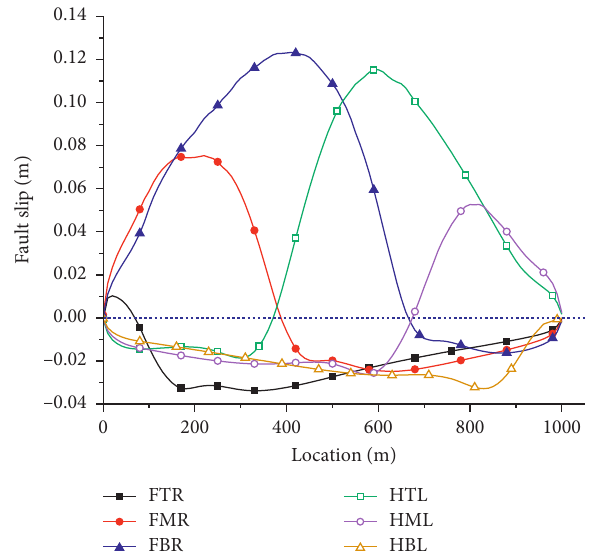
Figure 13: Fault slip along the fault plane when the fracturing region was FTR, TBR, FMR, HTL, HML, or HBL. plane (black line with the square symbol) presented in two sections: from 0 m to 60 m, the fault slid upward; from 60 m to 1000 m, the fault slid downward. It caused the fault to be tensioned at the point of 60 m and prone to failure. The largest fault sliding distance was 33.81 mm, and the average sliding distance was 21.43 mm. The M w of the induced earthquake was 3.0214. When the fracturing region was FMR (red line with the circle symbol), the fault slip also presented in two sections, but the range of sliding upward increased (0 m–380 m). The largest sliding distance, average sliding distance, and M w of the induced earthquake were